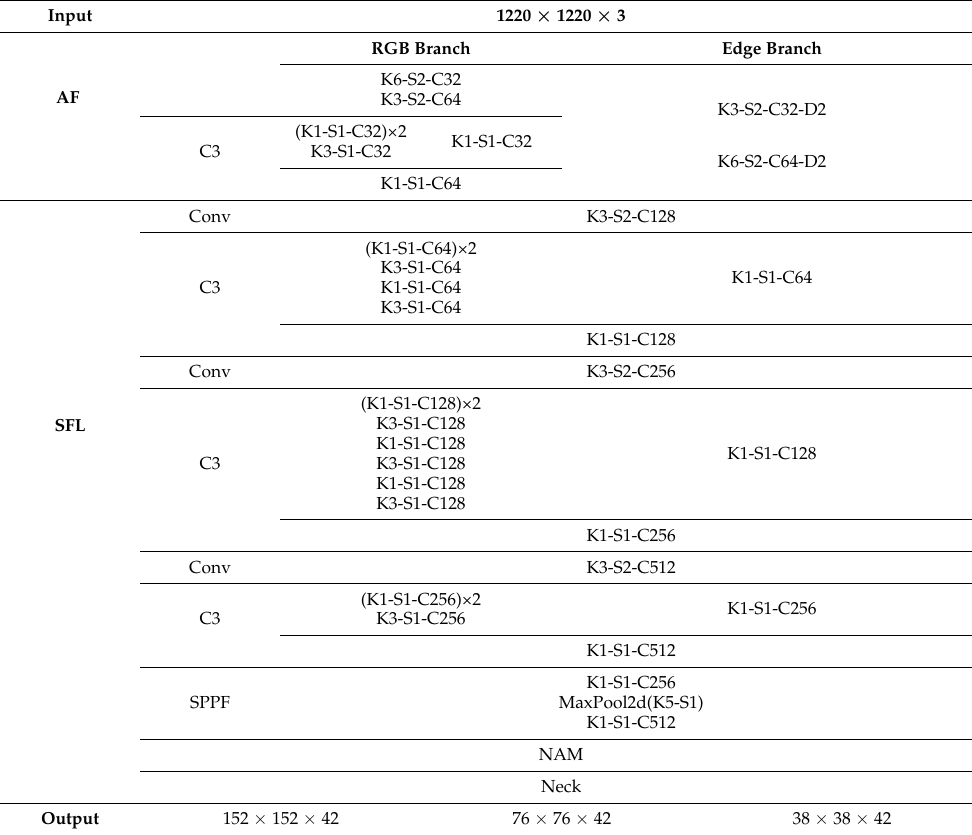
Table 2. Design details of the proposed